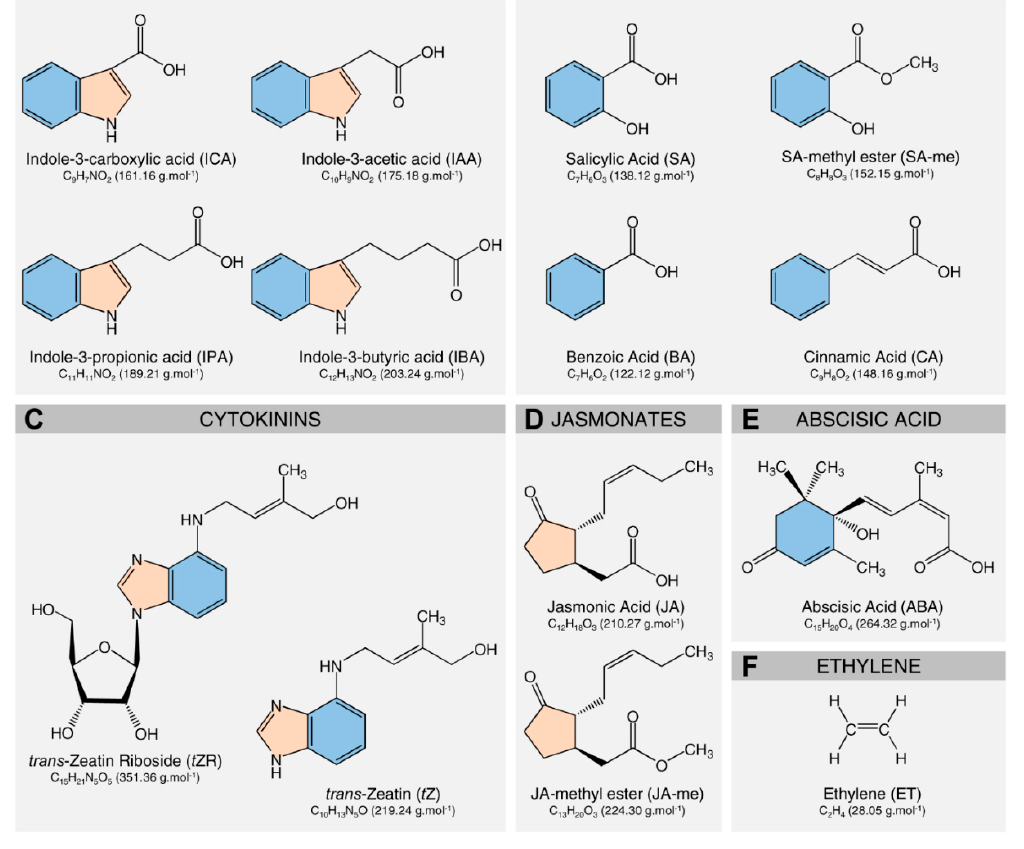
Figure 2. The chemical structures of different phytohormones discussed throughout this review. ( A ) auxins, ( B ) salicylates, ( C ) cytokinins, ( D ) jasmonates, ( E ) abscisic acid, and ( F ) ethylene. Molecular weights (g · mol − 1 ) are mentioned between parentheses beside the chemical formula of each compound.